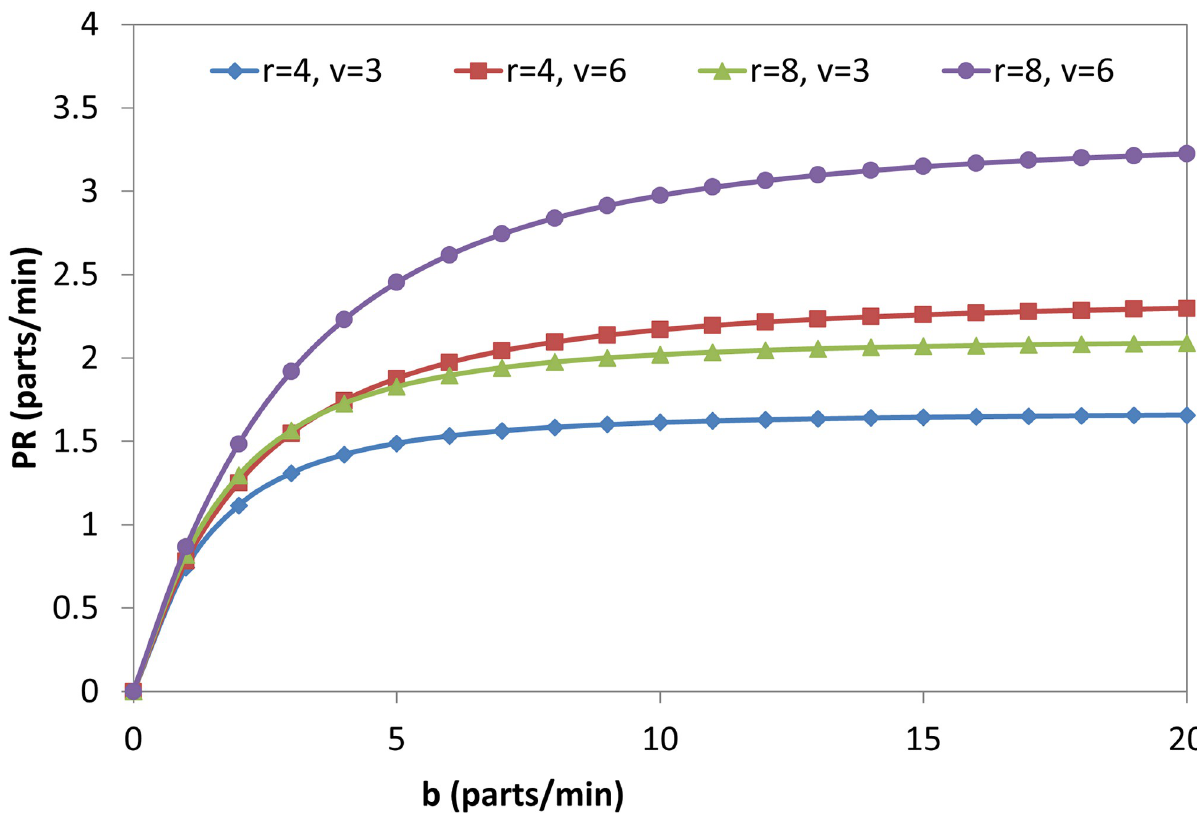
Fig 9. PR-b diagram for single-machine